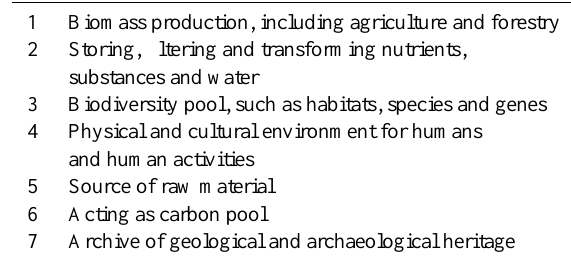
Table 2. The seven soil functions (SFs) as defined by the European Commission (EC, 2006).